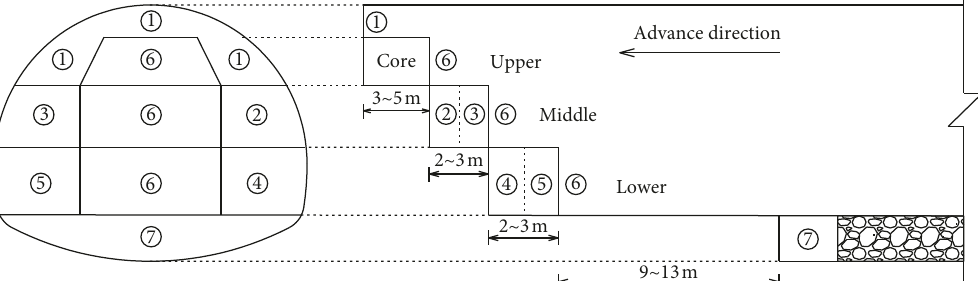
Figure 8: Schematic diagram of the three-bench and seven-step excavation method.